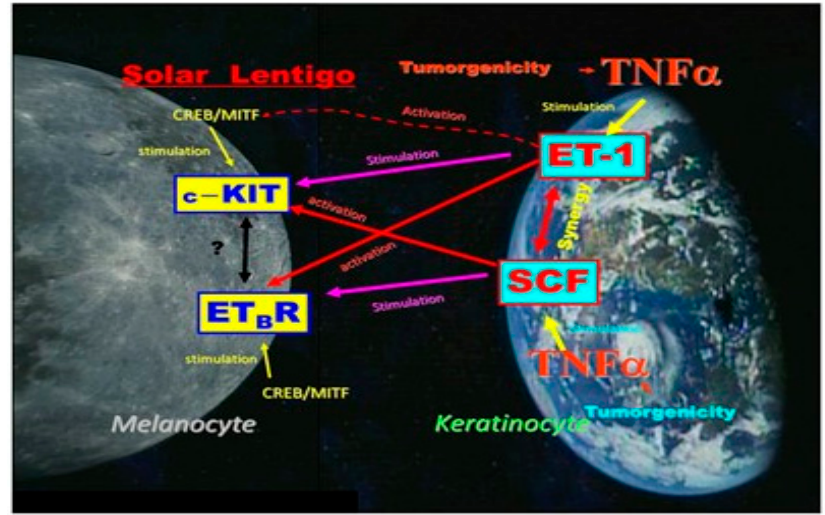
Figure 4. A summary of the complex mutual relationships between SCF and EDN1 linkages in the lesional epidermis of SLs.